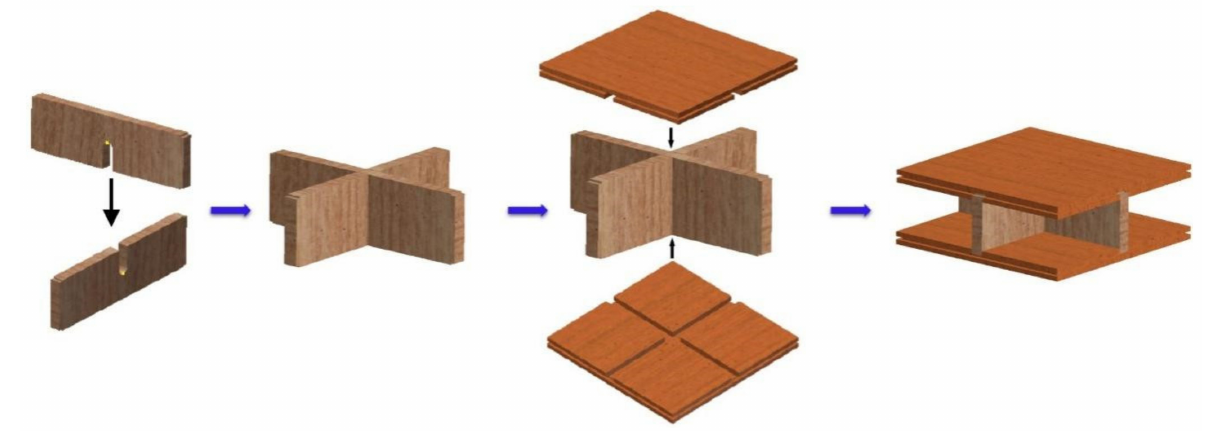
Figure 6. Fabrication of interlocking grid